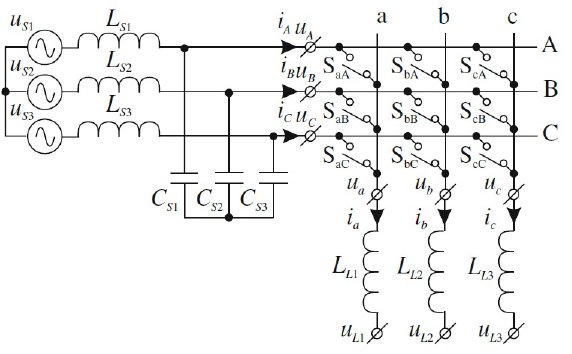
Figure 1. Three-phase matrix